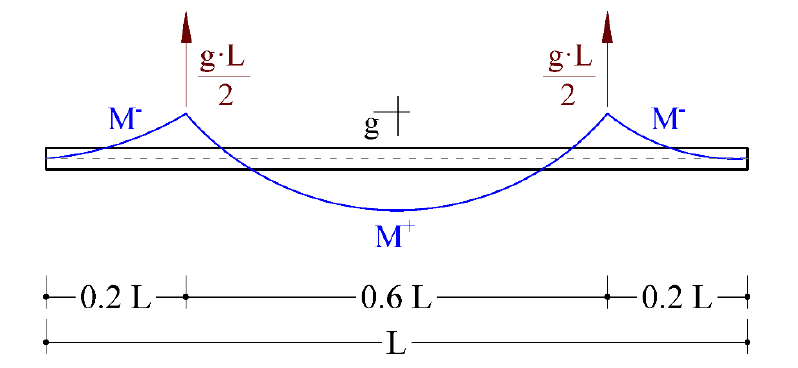
Figure 1. Example of beam and panel lifting